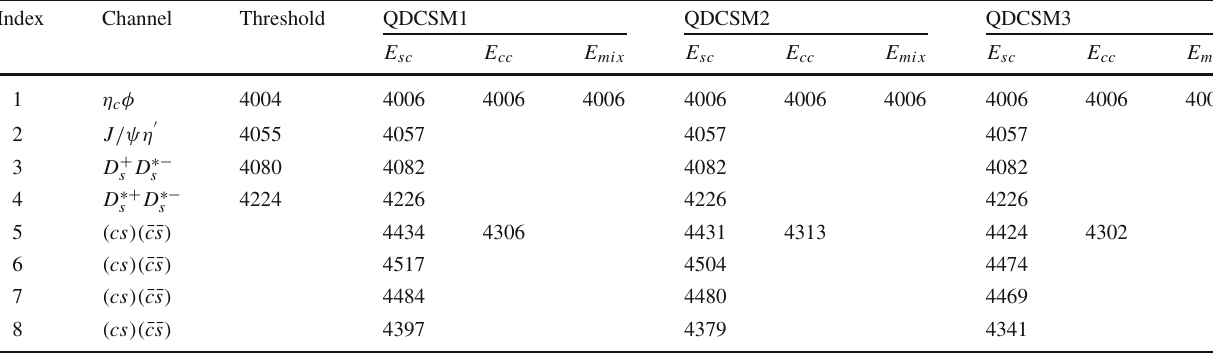
Table 6 The lowest-lying eigenenergies (in MeV) of c ¯ cs ¯ s tetraquarks with J PC = 1